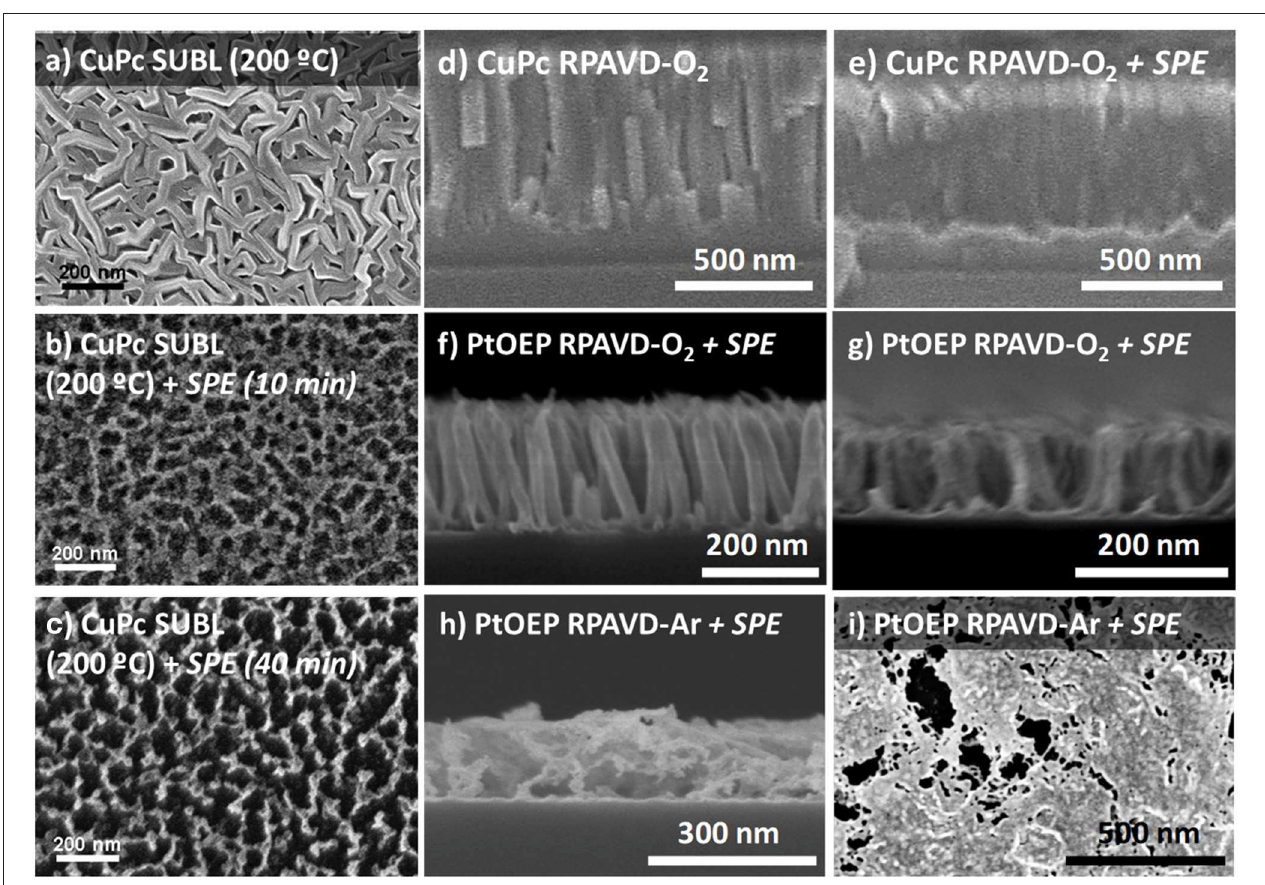
FIGURE 4 | (a-i) Planar view and cross-section SEM micrographs representative of the soft-plasma etching results as